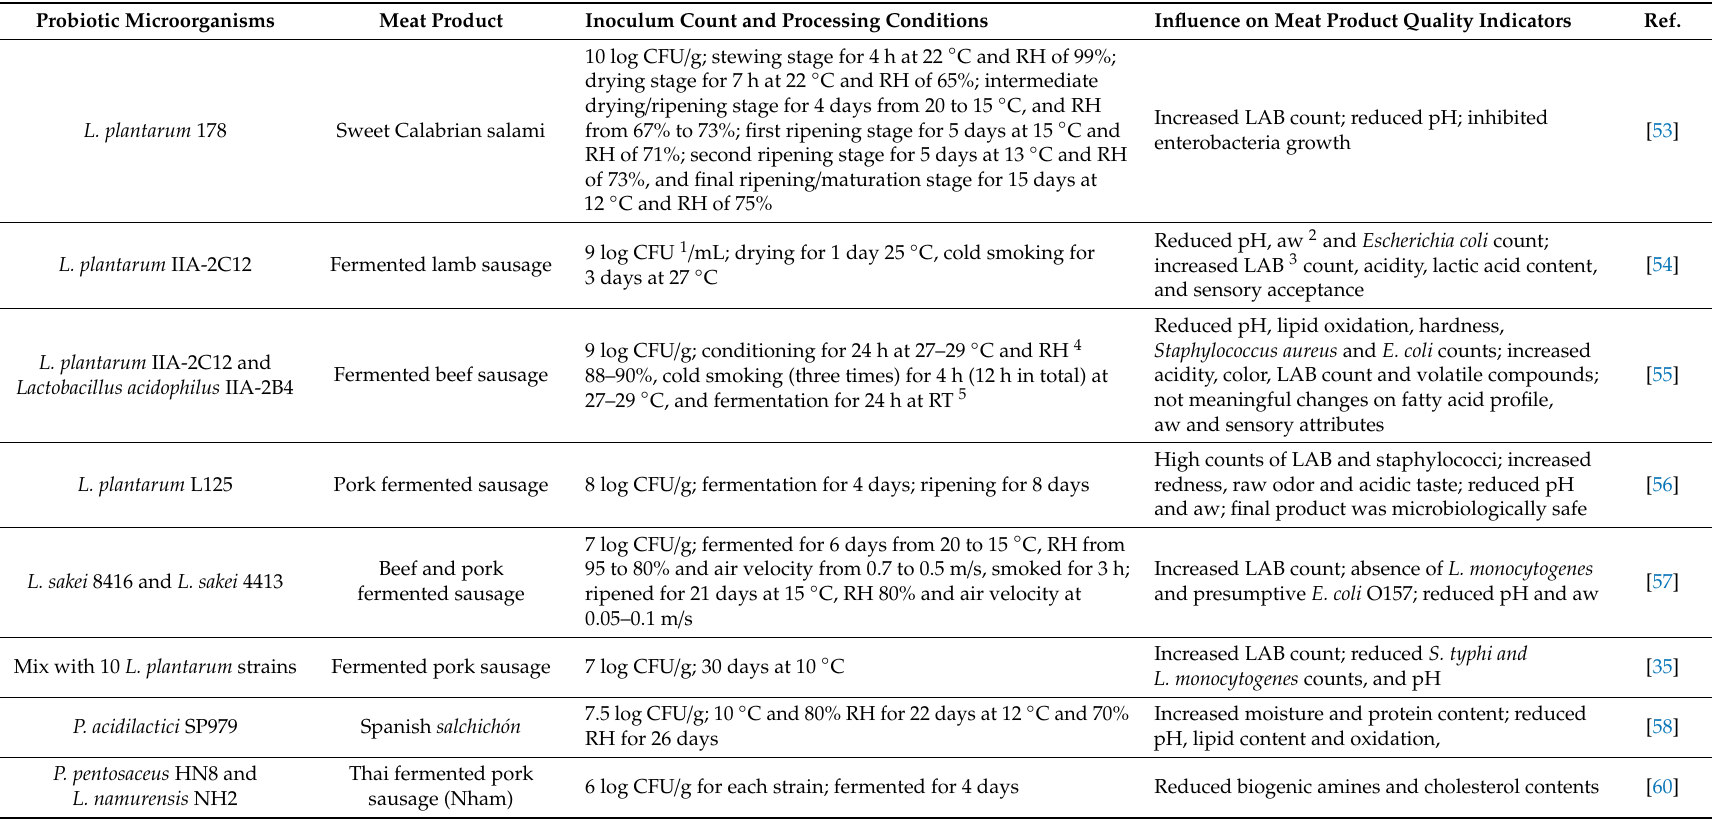
Table 2. Influence of probiotic strains as starter cultures in meat